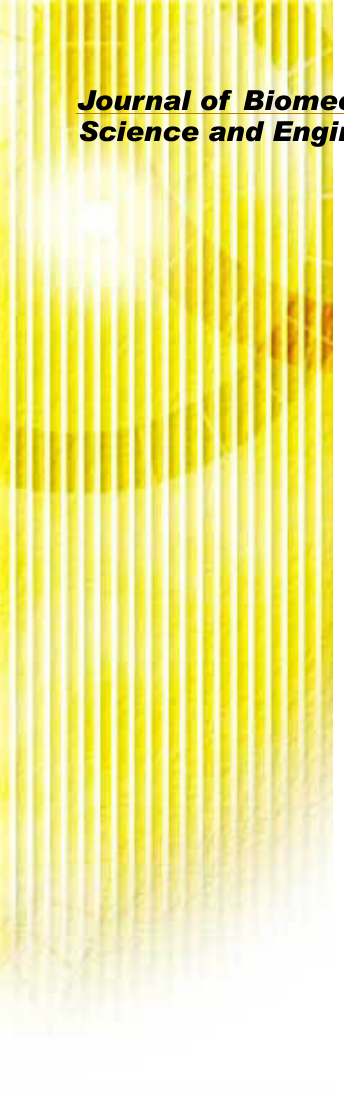
Fig. 8 Morphology of network structure analyzed in detail. Centroid of networks (A) and tomogram in which network extends the longest distance (B) were used as morphological indexes. Data are mean ± S.E. ** P < 0.01 vs. medium-bFGF